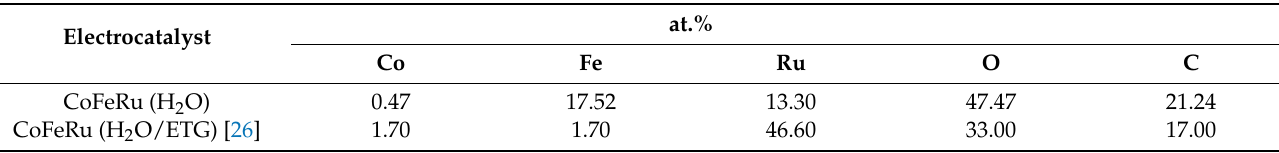
Table 1. EDS of CoFeRu electrocatalysts synthesized in deionized water and in a mixture of ethylene-glycol/deionized-water (ETG/H 2 O). at.% Electrocatalyst